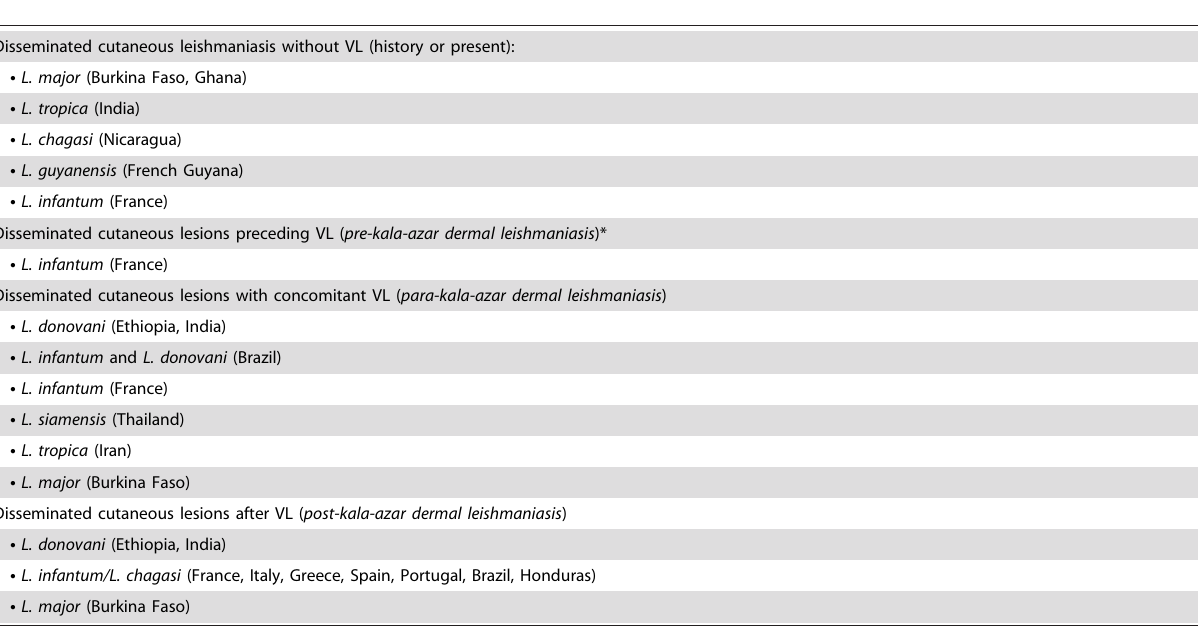
Table 3. Clinical entities particular to HIV and Leishmania co-infection and with reported causative parasite and region: a new terminology based on the presence and time of presentation of VL in relation to the development of the cutaneous lesions.